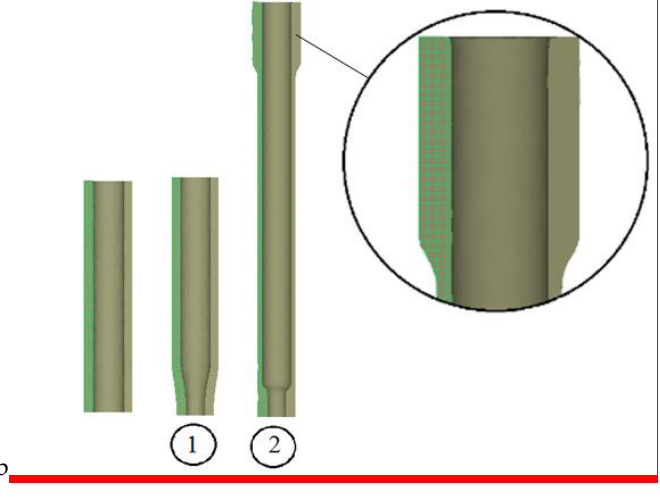
Figure 2. Forming with narrowing operations and flow forming.